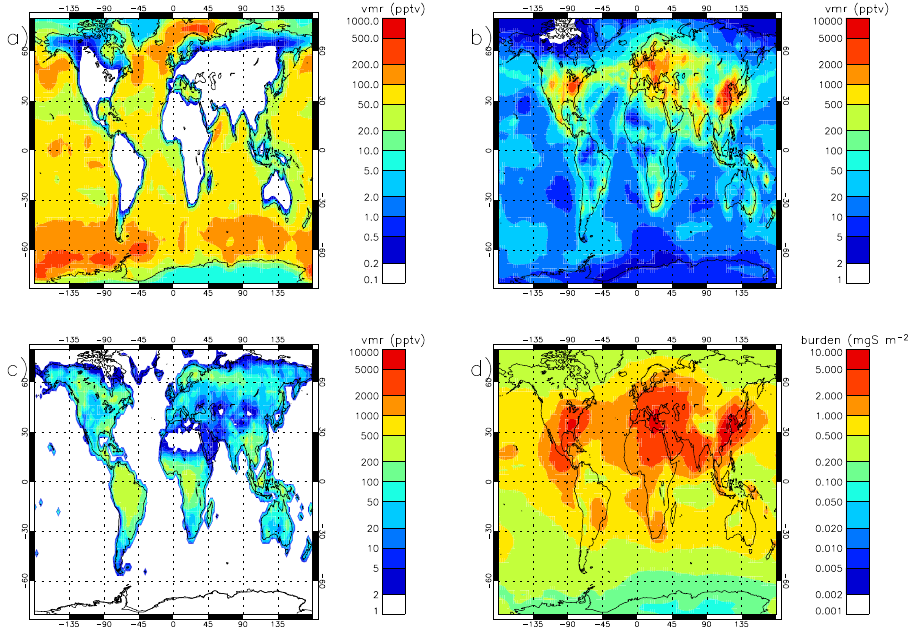
Fig. 1. Global maps of annual mean model surface vmr of (a) DMS; (b) SO 2 ; (c) terpenes in the model lowest level. Annual mean model column integrated aerosol sulfate burden is shown in panel (d)